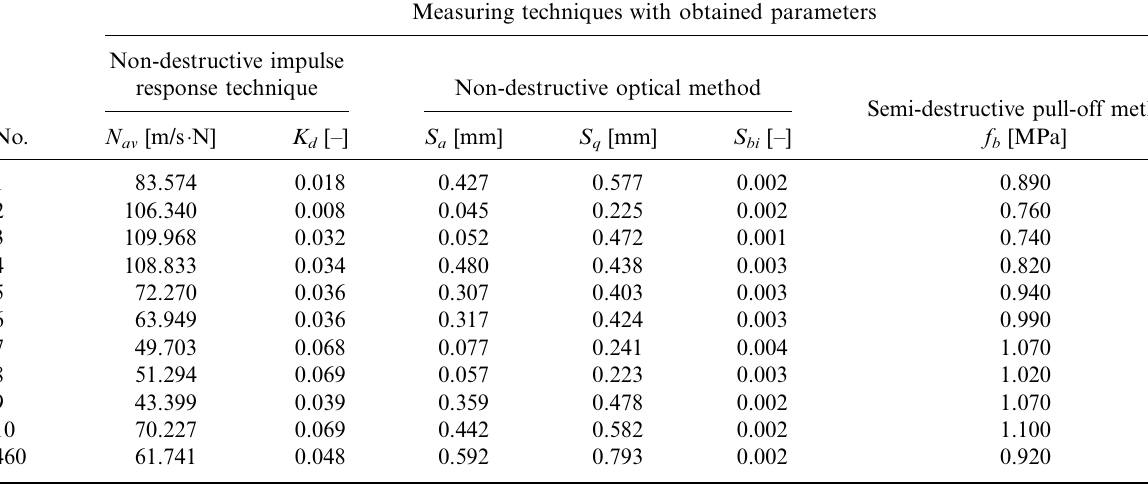
Table 1. Exemplary test results selected for training, testing and verification Measuring techniques with obtained parameters Non-destructive